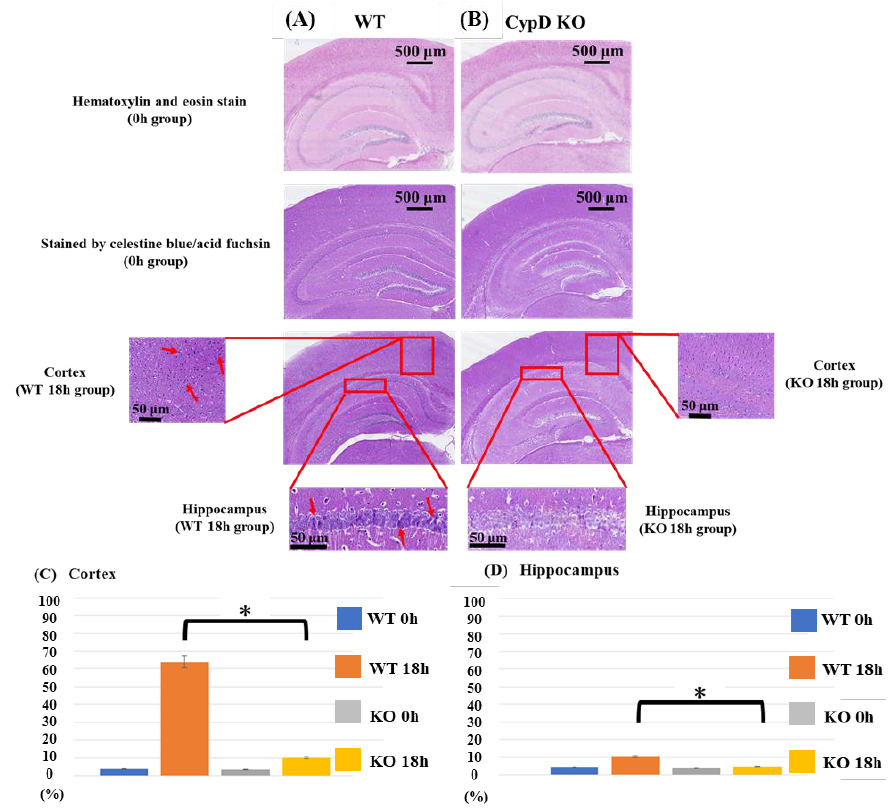
Figure 3. Histological analysis. Images from acid-fuchsin and celestine blue-stained sections represent neuronal necrosis of cortex and hippocampal areas from WT (sham-operated control ( A ) and from CypD KO mice ( B )). Neuronal damage in the cerebral cortex and the hippocampus was counted in a blinded manner and presented as the percentage number of damaged neurons (of the total number of cells). Tissues were harvested 18 h after surgery. Arrows indicate densely stained cells with high nuclear/cytoplasmic ratio, cellular swelling, and neuronal vacuolization. At 0 h after CLP treatment, there was no significant difference between the two groups regarding neither cere- bral cortex nor hippocampus. At 18 h, neuronal cell death was significantly more severe in both the cerebral cortex and hippocampus in the WT group as compared to the KO group ( C , D ). Data are expressed as means ± SD, * p < 0.05, n = 5.